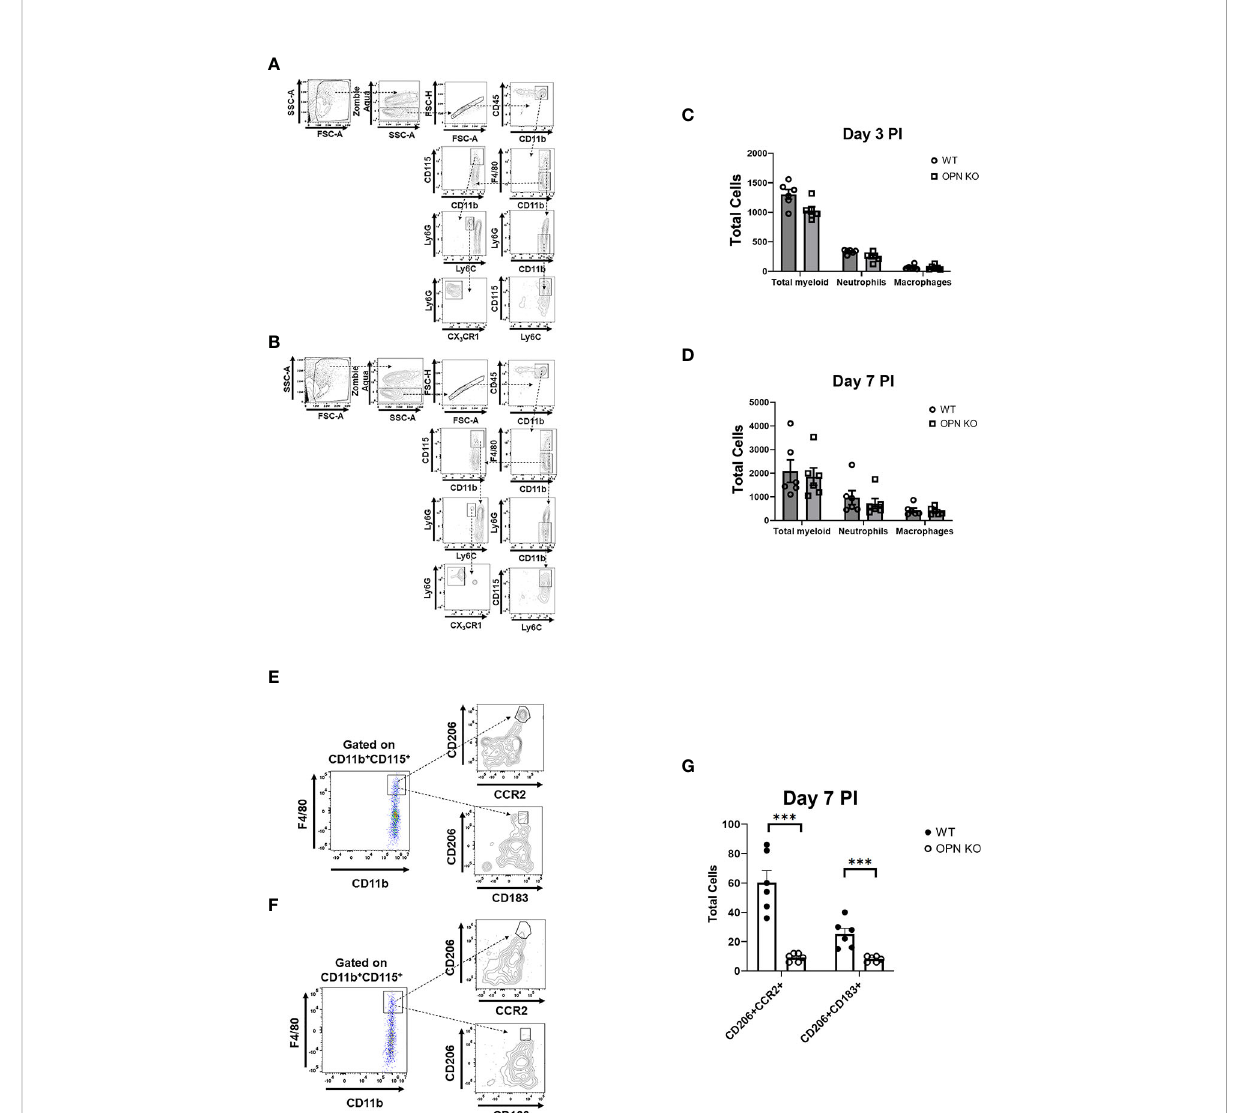
FIGURE 3 Myeloid-derived cell numbers are reduced in the cornea of OPN KO mice following HSV-1 infection. WT and OPN KO male and female mice (n=6/group) were infected with HSV-1 (350 PFU/cornea). At day 3 or day 7 PI, and corneas were removed from the mice and processed into single cell suspensions in a total volume of 100 µl. The cell suspensions were fi rst stained with Zombie Aqua for 15 minutes at room temperature and next washed with staining buffer. Next, cells were blocked with 1 µl anti-CD16/32 for 10 min at 4 0 C and then stained (30 minutes at 4 0 C) with anti-mouse conjugated antibodies to CD45, CD11b, CD115, CD183, CD206, CX 3 CR1, F4/80, Ly6C, and Ly6G. The samples were then acquired on an Aurora spectral fl ow cytometer, and the data analyzed using FlowJo software. Gating strategy for total myeloid, neutrophil, and macrophage populations with representative presentations from (A) WT and (B) OPN KO mice at day 3 PI. Summary of cell counts for total WT and OPN KO myeloid, neutrophil, and macrophage populations for (C) day 3 PI and (D) day 7 PI. Gating strategy for CD115 + CD206 + CCR2 + CD183 - F4/80 + CX 3 CR1 + and CD115 + CD206 + CCR2 + CD183 + F4/80 + CX 3 CR1 + macrophages found in the corneas of (E) WT and (F) OPN KO mice at day 7 PI. (G) Summary of cell counts for the designated macrophage populations from WT and OPN KO mice. Bars represent mean ± SEM ***p<.001. At day 3 PI, p=.06 comparing WT to OPN KO mice as determined by the Holm-Sidak